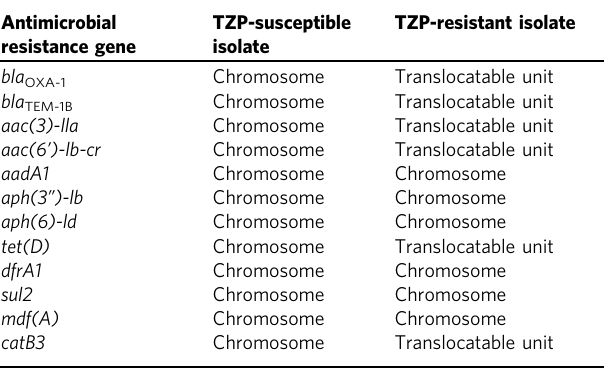
Table 2 Predicted antimicrobial resistance genes. Antimicrobial resistance